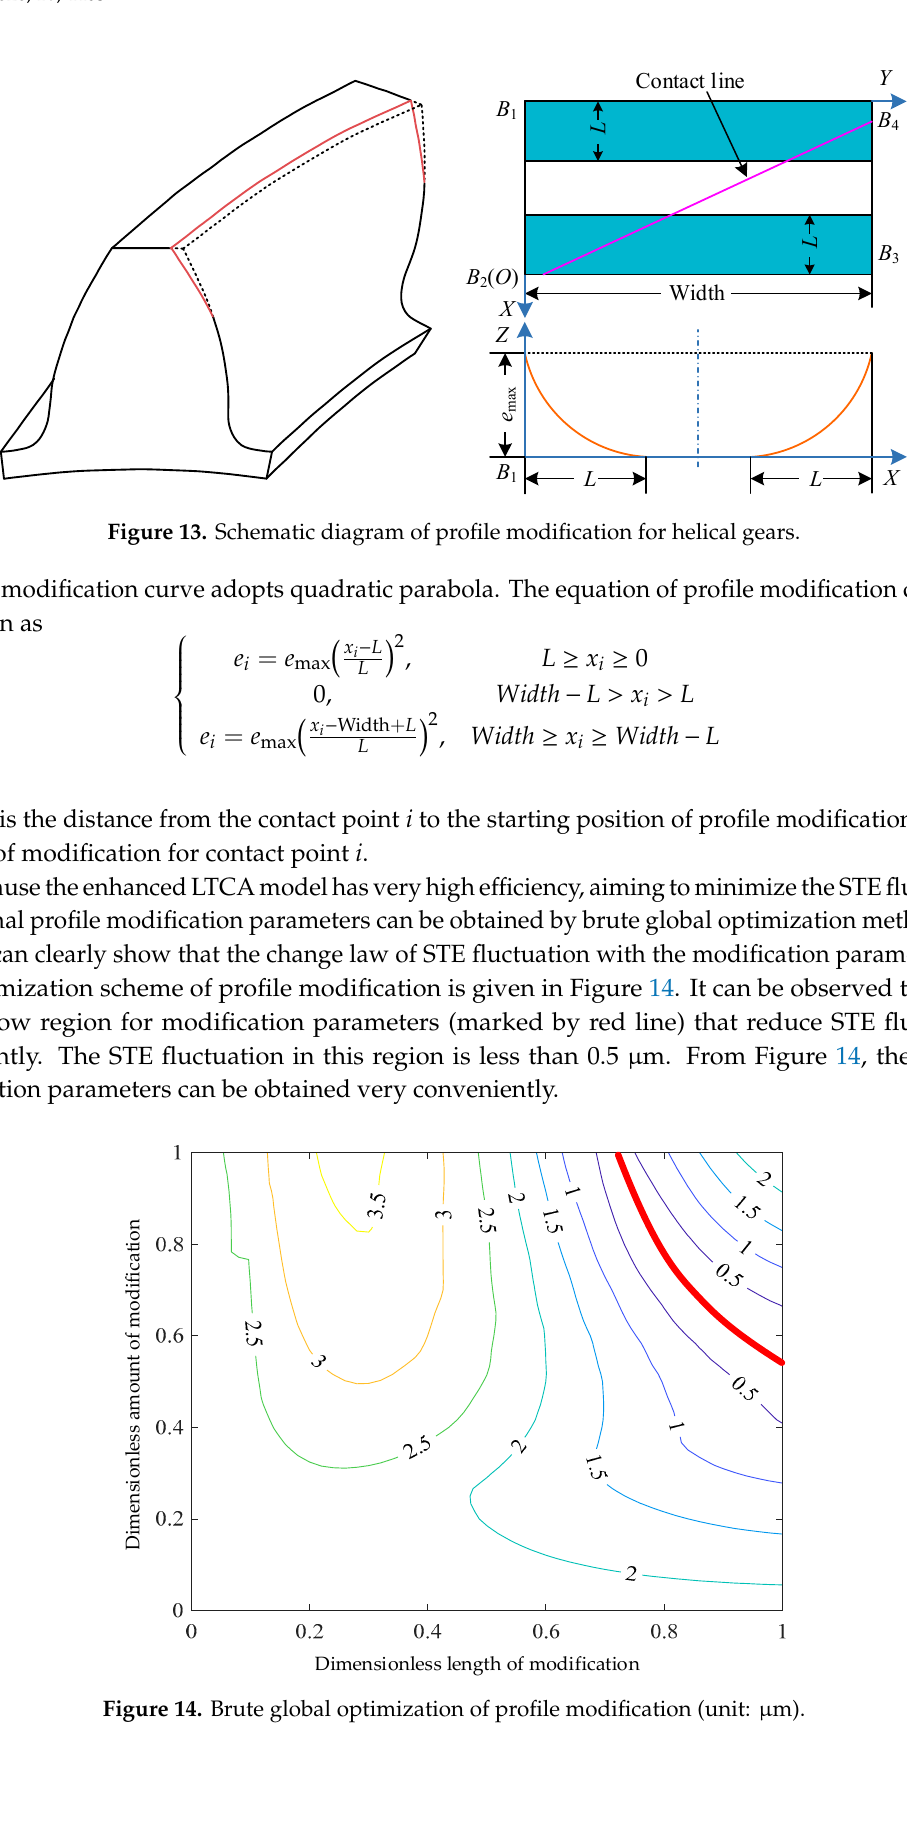
Figure 14. Brute global optimization of profile modification (unit: μ m).